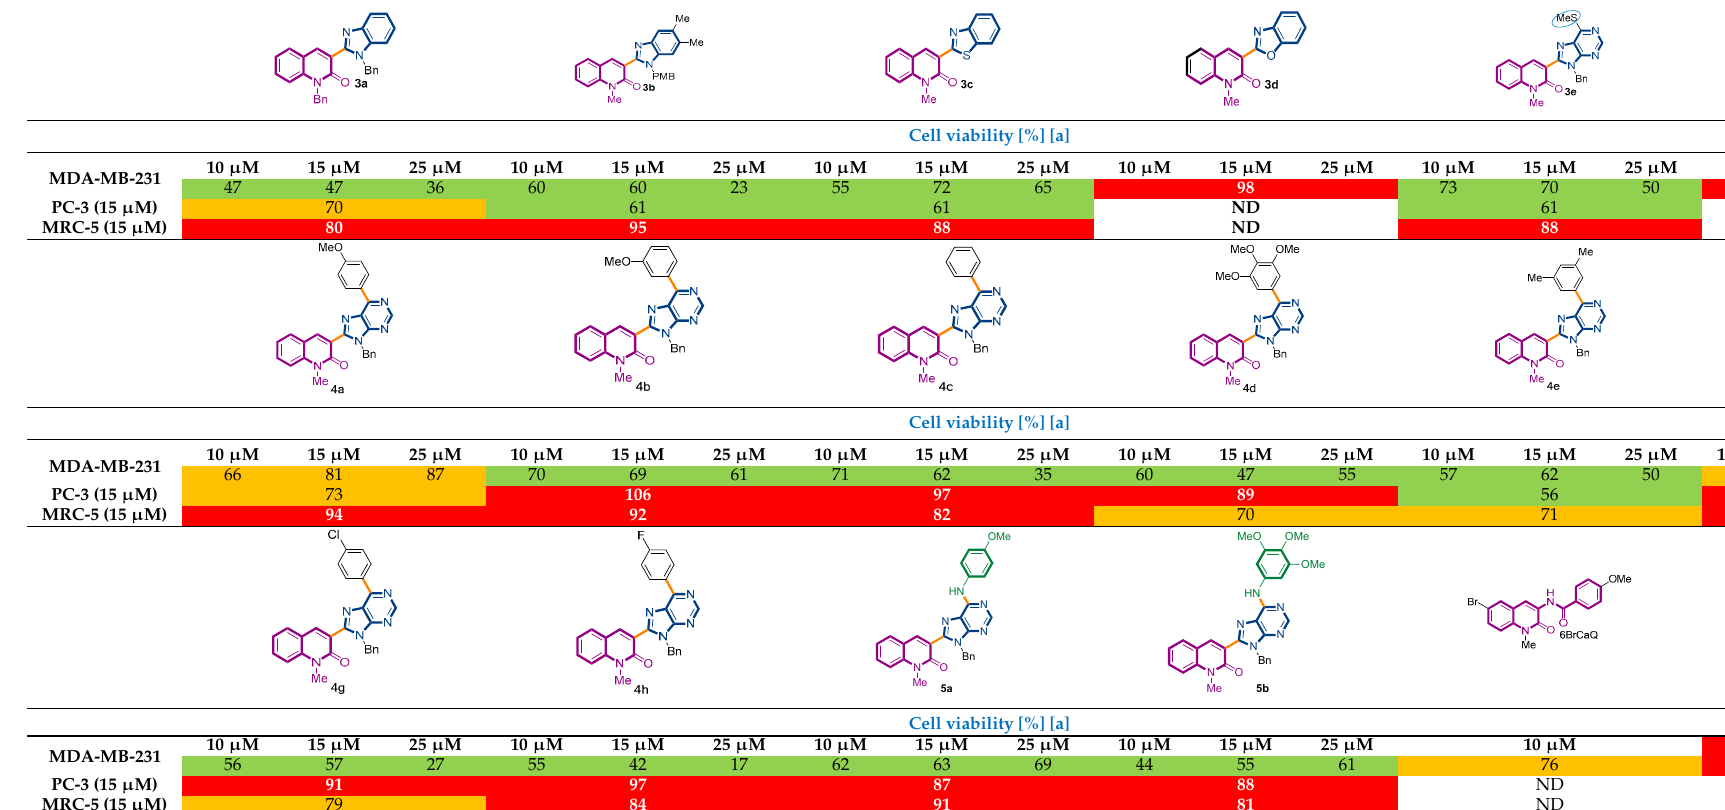
through cell metabolic activity (MTS-based assay).